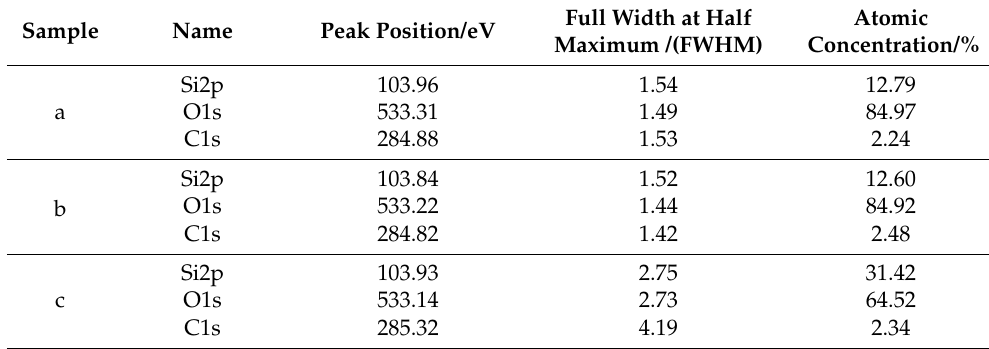
Table 2. XPS element analysis results of samples.